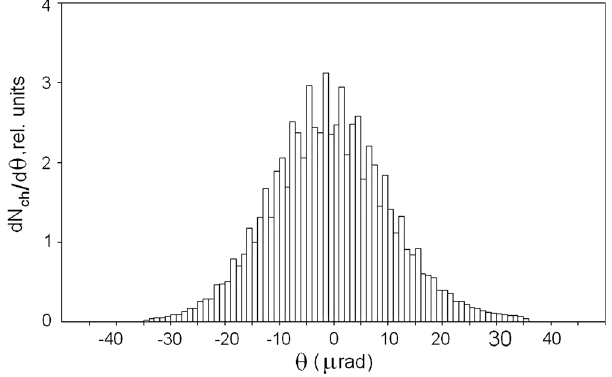
FIG. 7. The distribution of 400 GeV =c beam protons as a function of the angle θ .